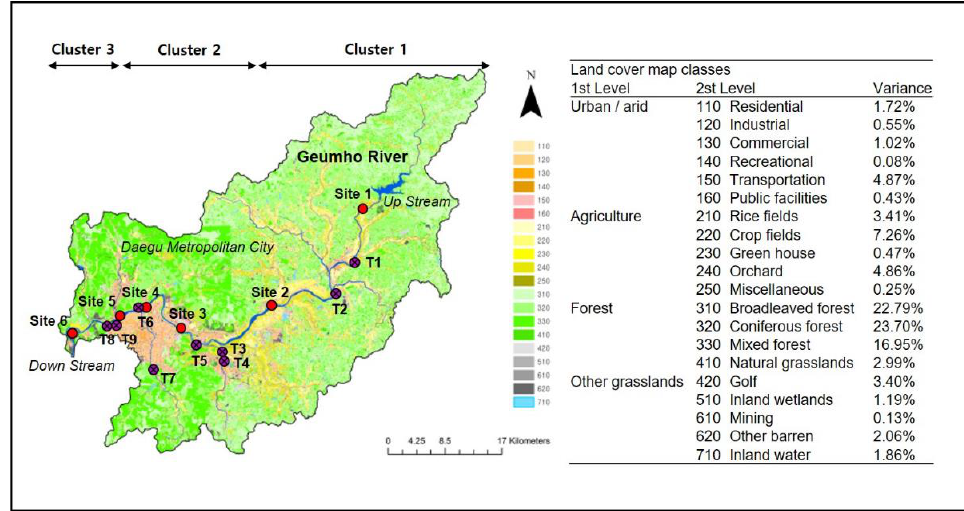
Figure 5. Land cover map of the target watershed drawn using Arc-GIS. Land cover codes 110 to 160 are urban (orange series), 210 to 250 are agriculture (yellow series), 310 to 330 are forest (green series), etc. Red point, monitoring sites (S1 to S6); purple point, sewage and wastewater treatment facilities (T1 to T9).